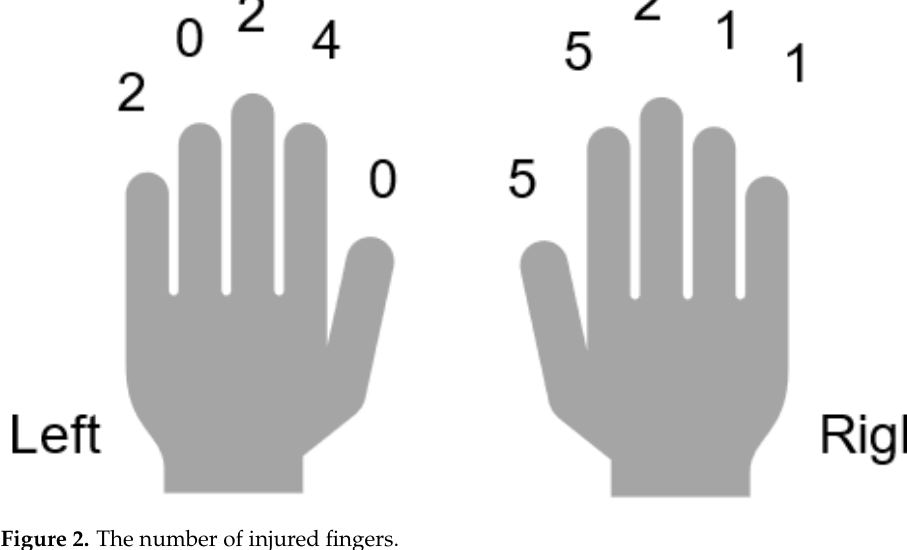
Figure 2. The number of injured